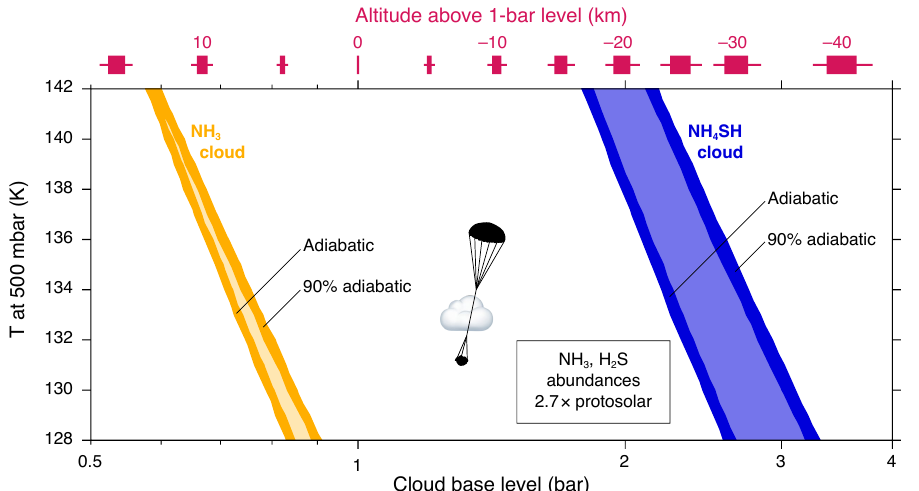
Figure 18. Over the range of plausible Jovian thermal conditions considered in this work, upper clouds of NH 3 (gold) or NH 4 SH (blue) form only at pressures < 3.2 bar. Shaded regions are bounded by adiabatic and 90% adiabatic lapse rates. Sensitivity to lapse rate increases with pressure, due to the larger vertical distance from the 500-mbar boundary condition. The same effect can be seen in Figure 16, where slopes of contour lines grow increasingly shallow at greater pressures. Red upper tick marks show the altitude scale, which varies in each case depending on the temperatures and lapse rates tested. The horizontal red line indicates the maximum and minimum pressures for each altitude, while the box gives the interval ± 1 standard deviation. The cloud symbol shows the pressure level of a cloud detected by the Galileo Probe [133], plotted against the 500-mbar temperature in the probe site [118]. This cloud, located in a “dead zone” where NH 3 cannot condense and NH 4 SH condensation is not efficient, is discussed in Section